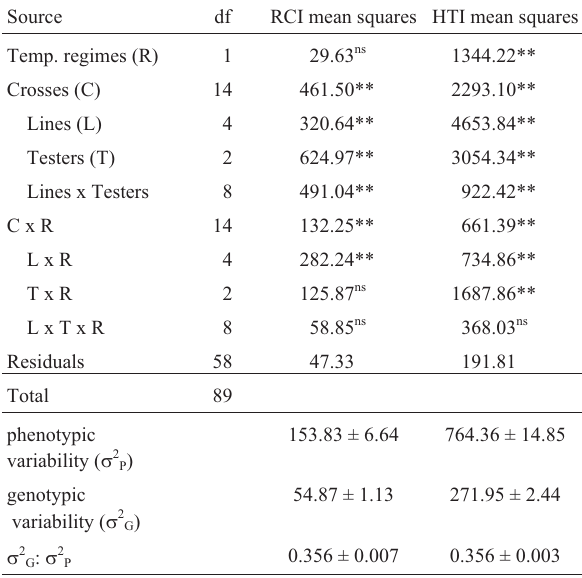
Table2 -Meansquaresfromtheanalysesofvarianceofcombiningability in crosses of upland cotton for cellular membrane thermostability (CMT) as measured by relative cell injury (RCI) across temperature regimes and heat tolerance index (HTI) across